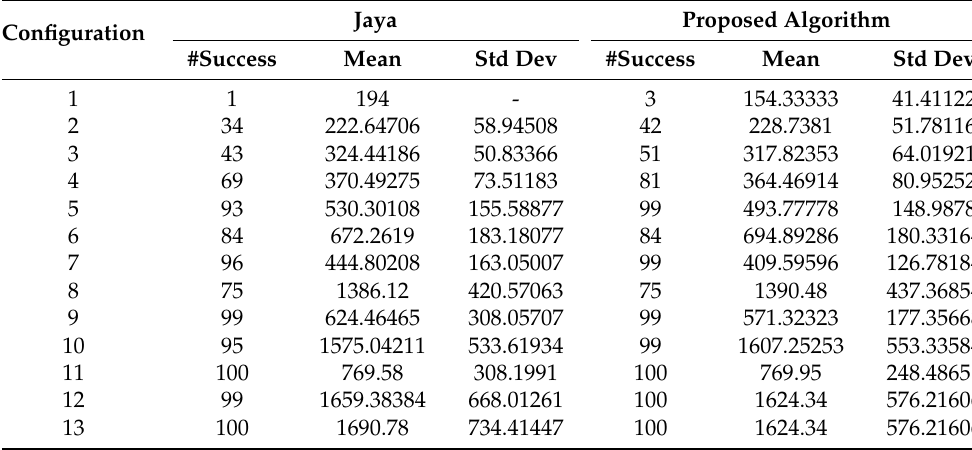
Table 7. Mean and standard deviation of firstHitEvals (each row is obtained from 100 independent runs for each